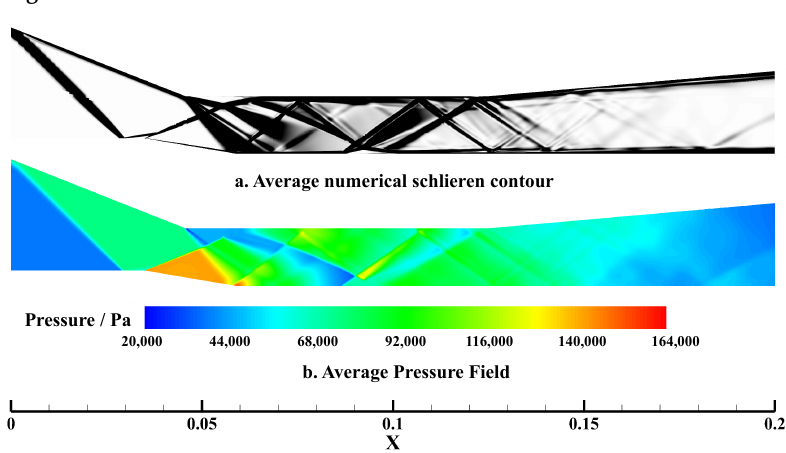
Figure 16. LES simulation: Mach field.